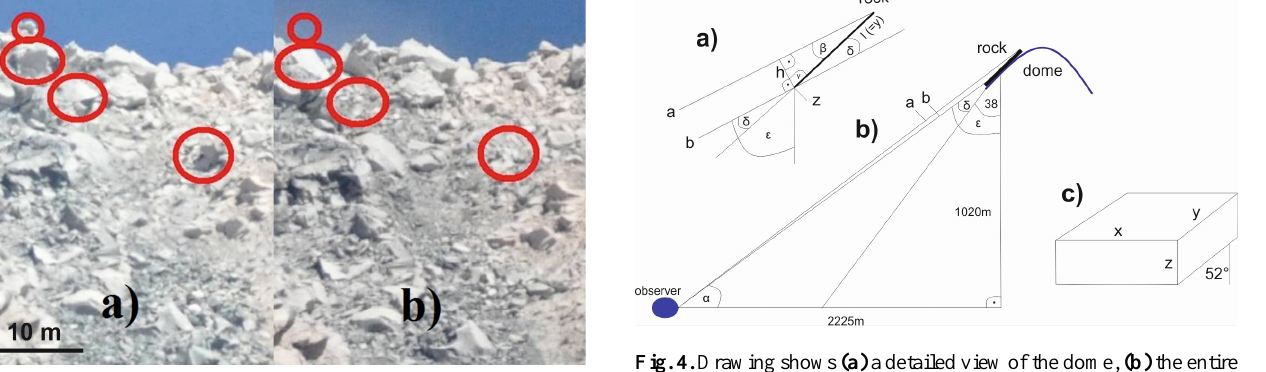
Fig. 3. View of the dome of Volc´an de Colima (a) before the rock- fall on the 8 March 2011, 15:02 LT (21:02 GMT) and (b) after the rockfall. Rocks that are missing after the rockfall are marked with a red